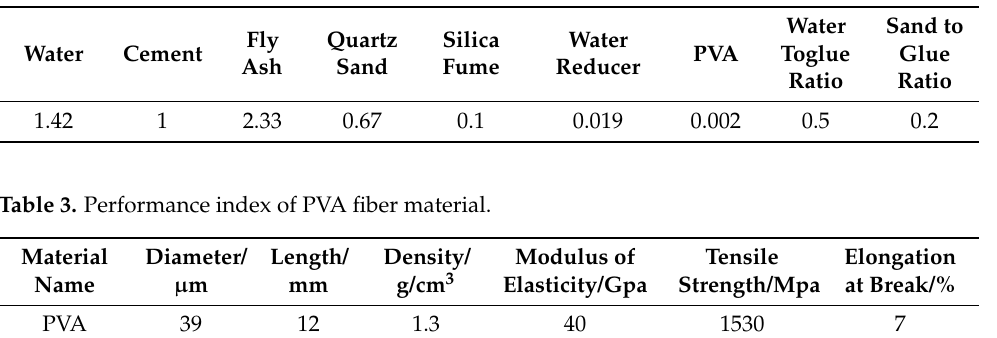
Table 2. ECC matrix mix ratio (quality ratio).